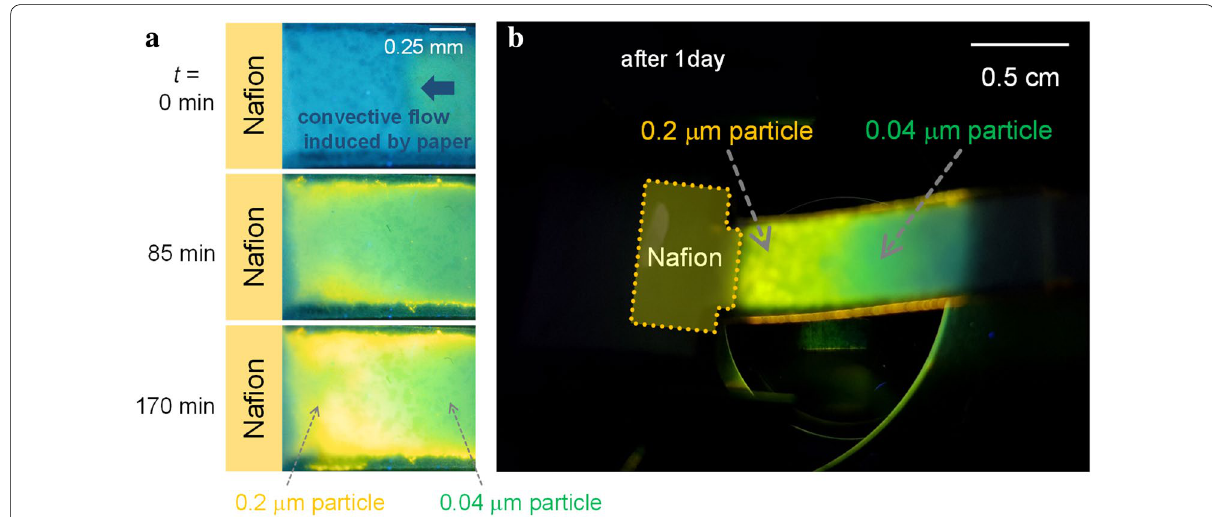
Fig. 3 a Time-evolving microscopic images of spontaneous diffusiophoretic separation and b the separated particles captured by regular cellphone